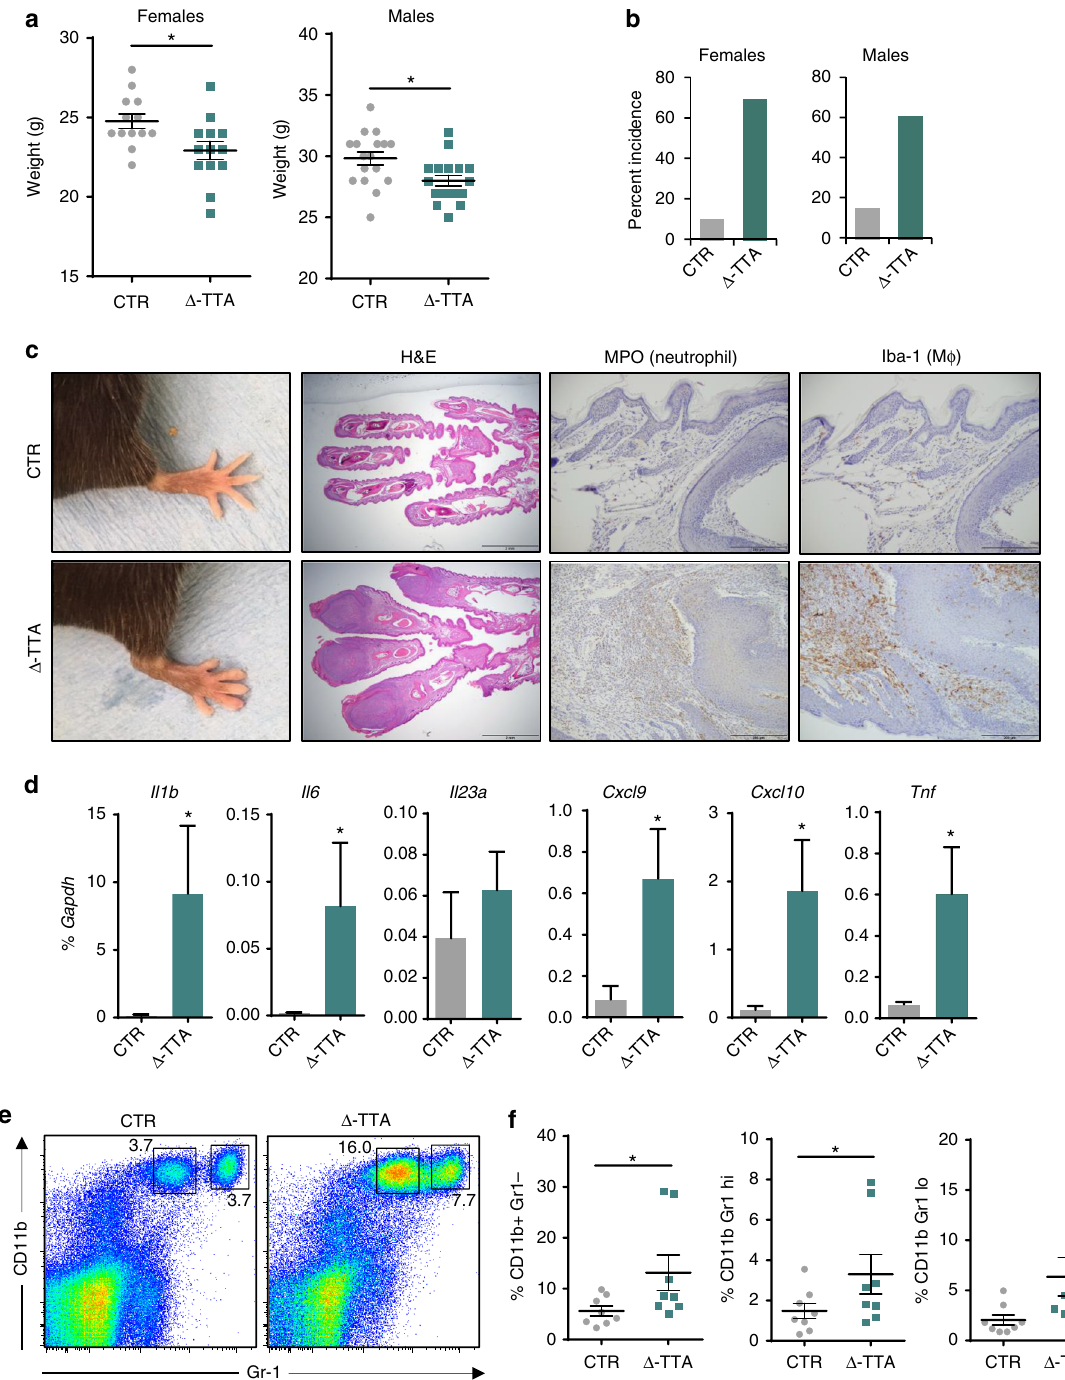
Fig. 6 Δ -TT > A mice develop spontaneous arthritic phenotype with age. a Whole-body weights of CTR and Δ -TT > A mice at 12 months of age ( n = 13 for females and 17 for males). Results are shown as mean ± s.e.m., statistical signi fi cance was determined using unpaired two-tailed t -test, * P < 0.05. b The cumulative incidence of arthritis in CTR ( n = 14 for females and 25 for males) and Δ -TTA ( n = 18 for females and 19 for males) mice ≥ 11 months of age. c Photographs of hind paws of CTR and Δ -TTA mice at ≥ 11 months of age; photomicrographs of sections of paws and digits stained with H&E (scale bars, 2 mm), myeloperoxidase (MPO), and Iba-1 (anti-Iba-1) showing increased in fi ltration of neutrophils and macrophages; scale bars, 200 μ m. Photomicrographs are representative of 5 (CTR) and 6 ( Δ -TT > A) mice. d mRNA levels of Il1b , Il6 , Il23a , Cxcl9 , Cxcl10 , and Tnf in cells isolated from hind paws of CTR ( n = 7) and Δ -TT > A ( n = 7) mice at the age of ≥ 11 months. Results are shown as mean ± s.e.m., Wilcoxon matched-pairs signed rank test, * P < 0.05. e Flow cytometric analysis of CD11b+ and CD11b+Gr1+ cells from spleens of CTR and Δ -TT > A mice presented as e representative dot plots and f percentage of cells. Results are shown as mean ± s.e.m. Statistical signi fi cance was determined using Wilcoxon matched-pairs signed rank test, n =